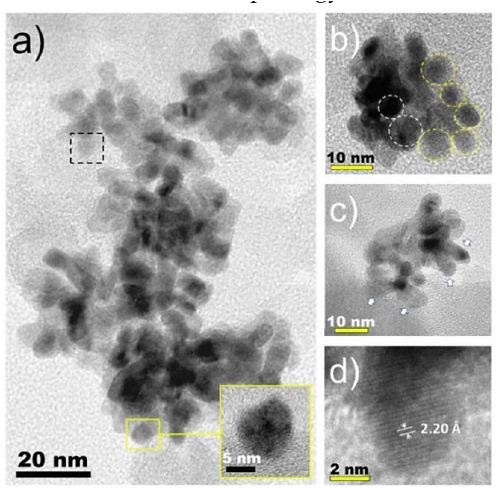
Figure 3. ( a ) STEM micrograph of the Pt 2 NiCo/C nanocatalyst before the electrochemical measurements. ( b , c ) Agglomerates constituted by nanoparticles of the Pt 2 NiCo/C catalyst. ( d ) Magnified view of the framed zone (dashed line) in ( a ).